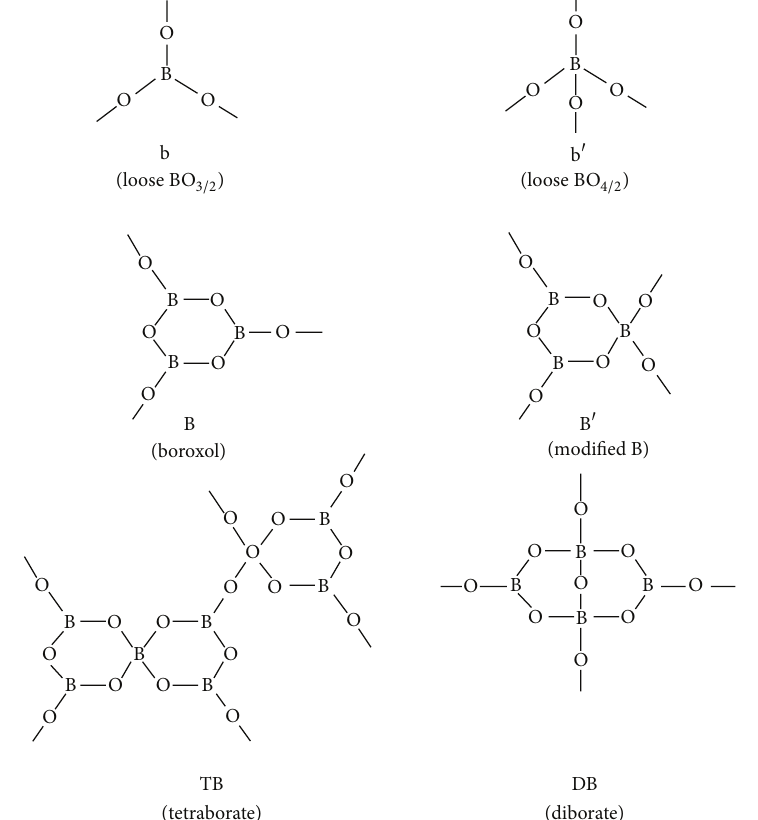
Figure 6: Different structural units in alkali borate glasses